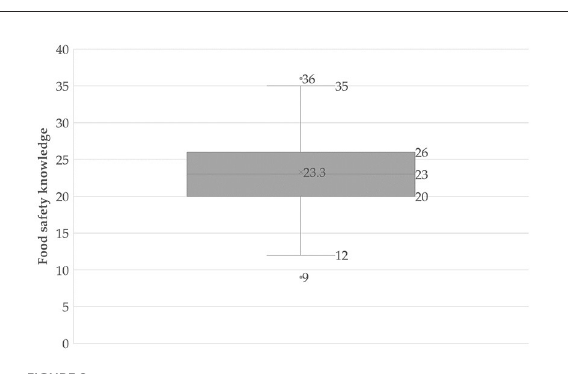
FIGURE2 Food safety knowledge among participants ( n =